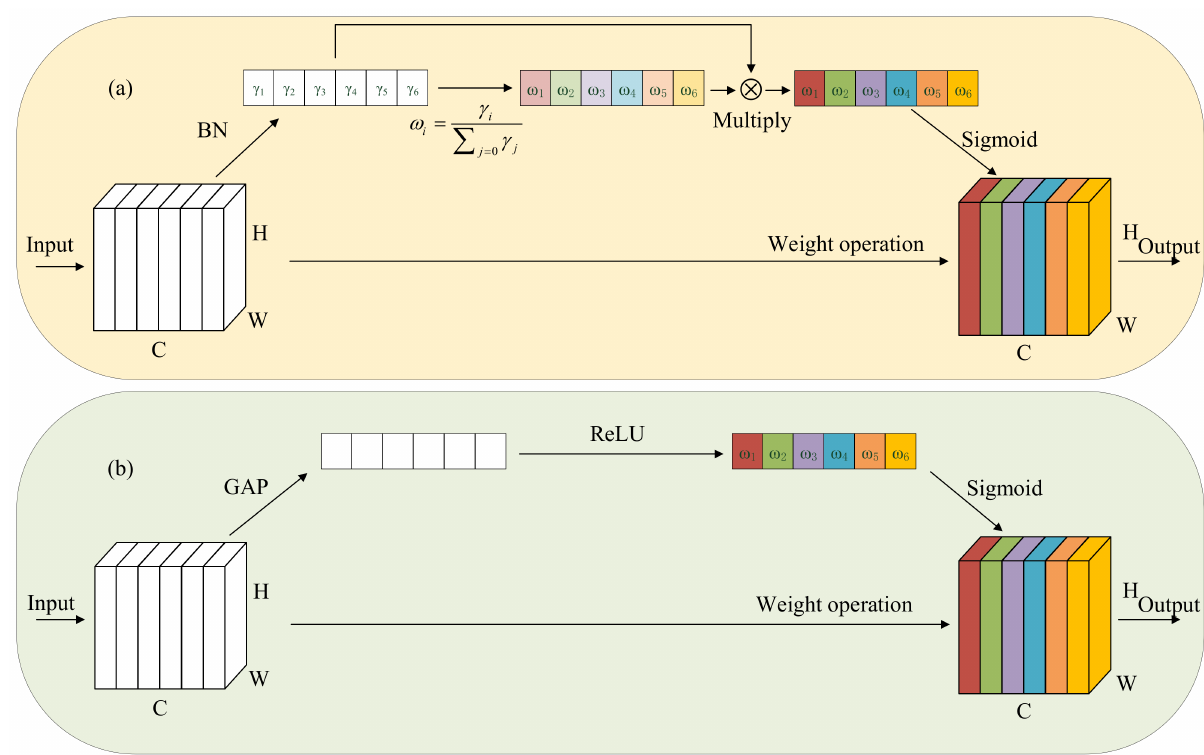
Figure 3. Pipeline of ( a ) normalization attention (NA) module and ( b ) Squeeze-and-Excitation (SE) module. The white cubes represent the unweighted feature maps, and the colored cubes represent the weighted feature maps. Different colors represent different weights. Light-colored rectangles indicate the low-level attention vector, and dark-colored rectangles indicate the high-level attention